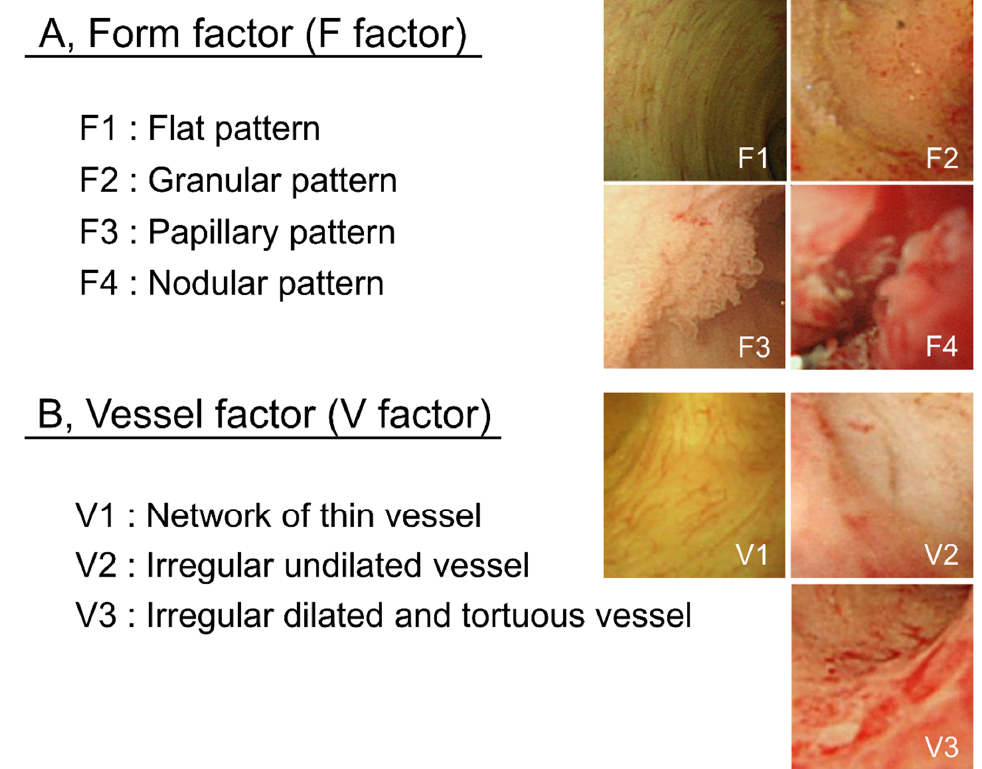
Figure 5. F–V classification of bile duct POCS findings. Bile duct epithelium POCS findings were classified into 4 surface structure groups (F1–F4) ( A ) and 3 vessel pattern groups (V1–V3) ( B ).